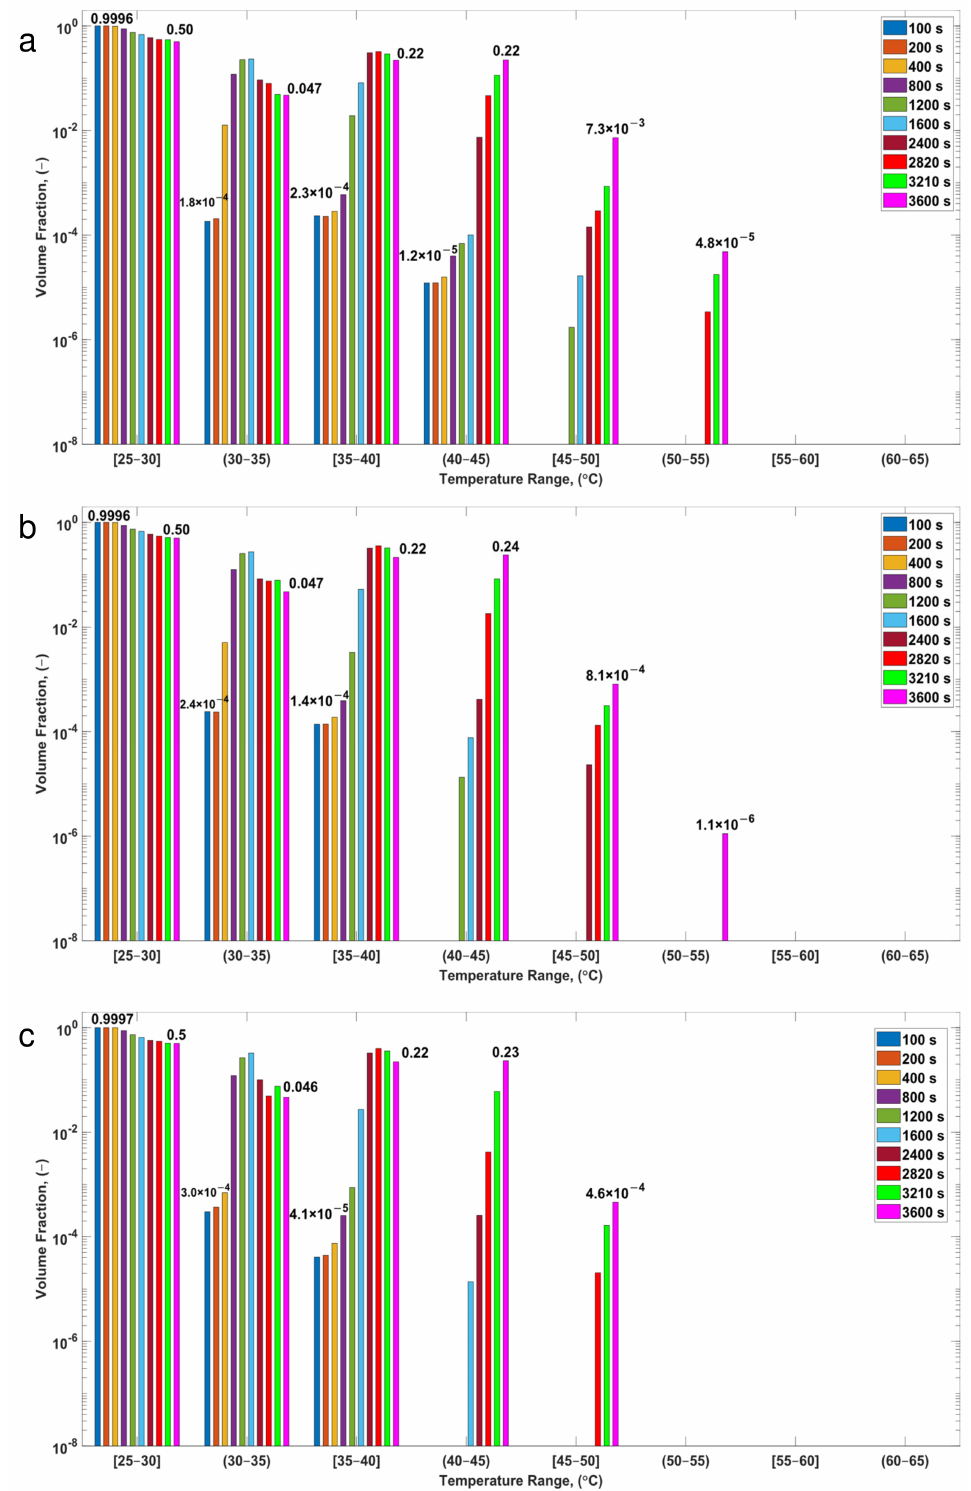
Figure 14. Temporal variation in volume fractions on a logarithmic scale with respect to the tempera- ture range in the suppression pool for number of heat sources: ( a ) two (Case G), ( b ) three (Case H), and ( c ) four (Case I) which are separated by 180 ◦ , 120 ◦ , and 90 ◦